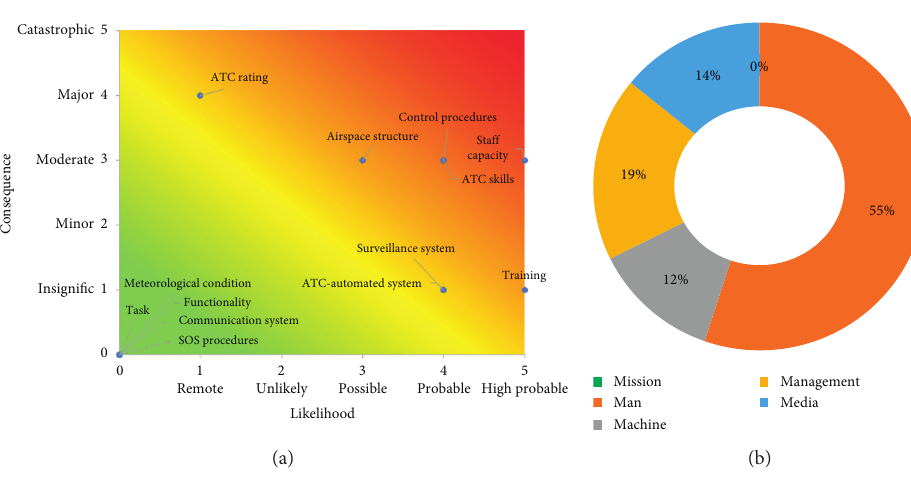
Figure 4: Risk assessment results. (a) Risk assessment heat map. (b) Risk category by total risk rating.